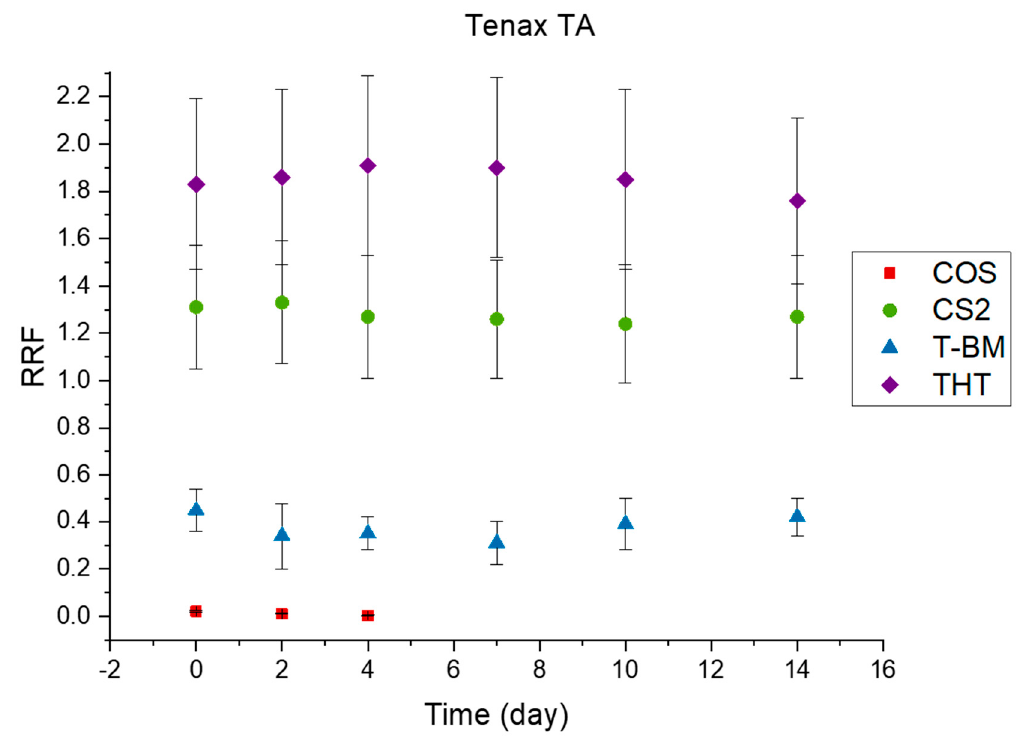
Figure 11. Storage stability of sulphur compounds (~20 nmol/mol) on Tenax TA.